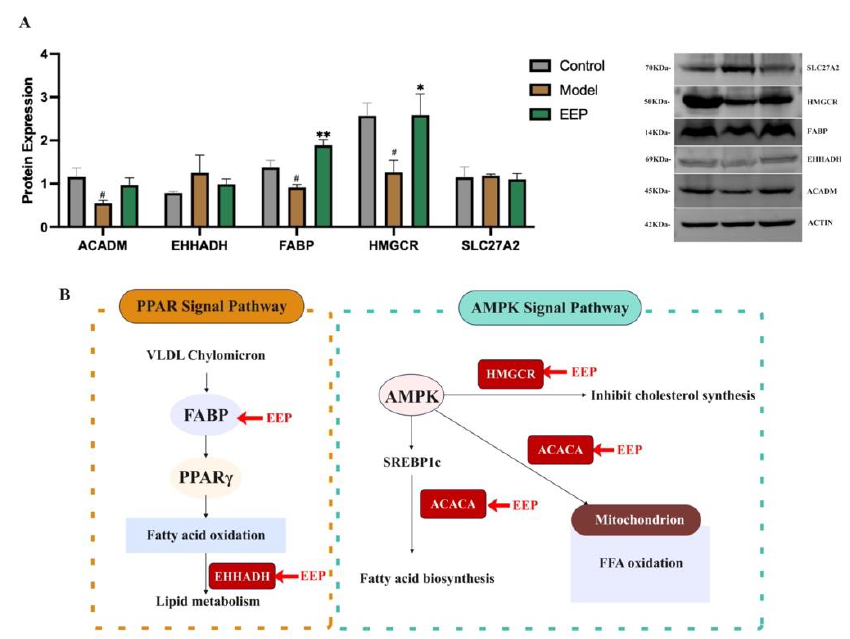
Figure 11. Antioxidant mechanisms of EEP via the AMPK and PPAR signaling pathways after hyperthyroidism challenge. ( A ) Effect of EEP on expressed of the AMPK and PPAR signaling pathways in hyperthyroidism mice ( n = 3). The protein expressed of ACADM, EHHADH, FABP, HMGCR, and SLC27A2 in liver. # p < 0.05 compared with Control group; * p < 0.05, ** p < 0.01 compared with Model group. Data were expressed as means ± SEM. ( B ) EEP activate protective antioxidant mechanisms on oxidative stress induced by hyperthyroidism via the AMPK and PPAR signaling pathways.